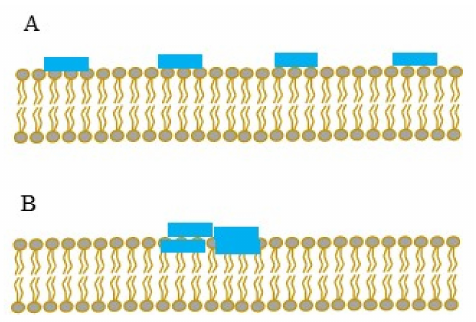
Figure 5. Peptide interaction with a lipid membrane with homogeneous ( A ) or heterogeneous ( B ) lateral